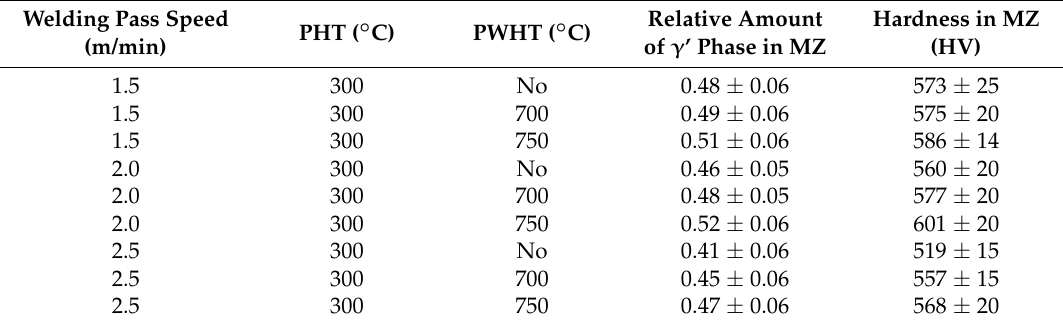
Table 3. Relative amount of γ ’ phase determined by X-ray diffraction (XRD) in MZ of samples welded and hardness with PHT = 300 °C and different pass speeds, before and after post-welding heat treatment (PWHT) at 700 and 750 °C for 2 h.